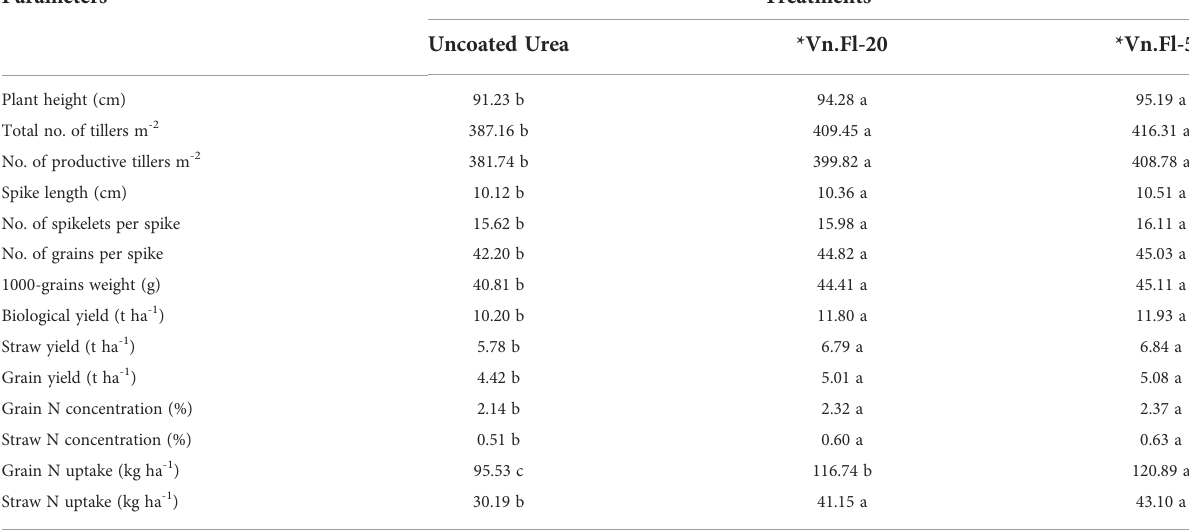
TABLE 3 The growth, yield, and N status of wheat supplied with different rates of Vachellia nilotica extract coated urea in fi eld conditions (2019-20).